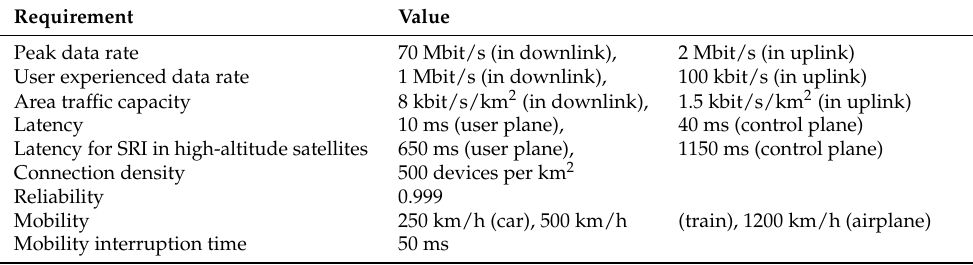
Table 2. Requirements in IMT-2020 for satellite radio interface